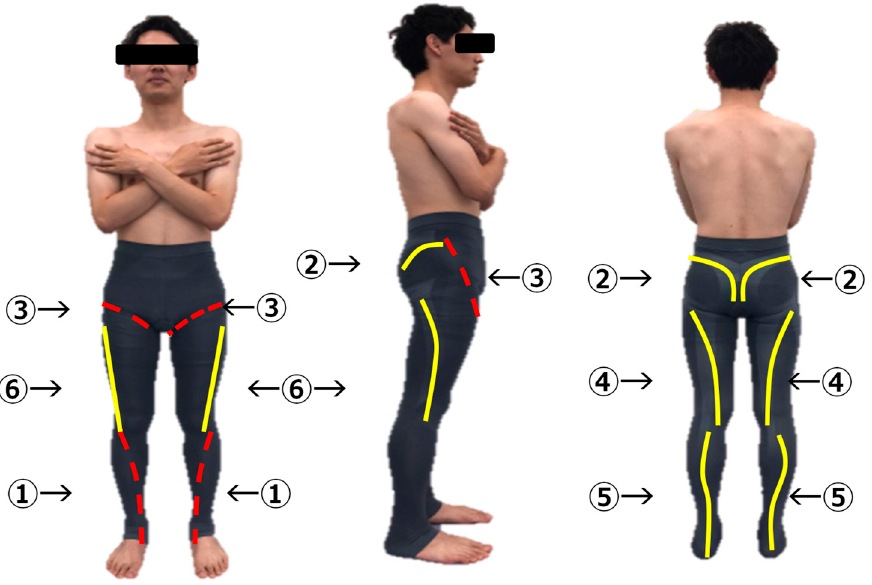
Figure 1. The FBG is designed for two important parts which are elastic support part and rigid support part. The elastic support part had designed by knitting and weaving with high elastic (solid line). The rigid part had designed by knitting and weaving with low elastic (dashed line). The main support function of lower extremity joint internal moment are as follows: ➀ Ankle dorsal flexion moment support during loading response, ➁ Hip extension moment support during loading response, ➂ Hip flexor moment support during Late stance, ➃ Knee flexor moment support during Late stance and Terminal swing, ➄ Ankle plantar flexion moment support during Late stance, ➅ Hip abduction moment support during loading response and Mid stance.